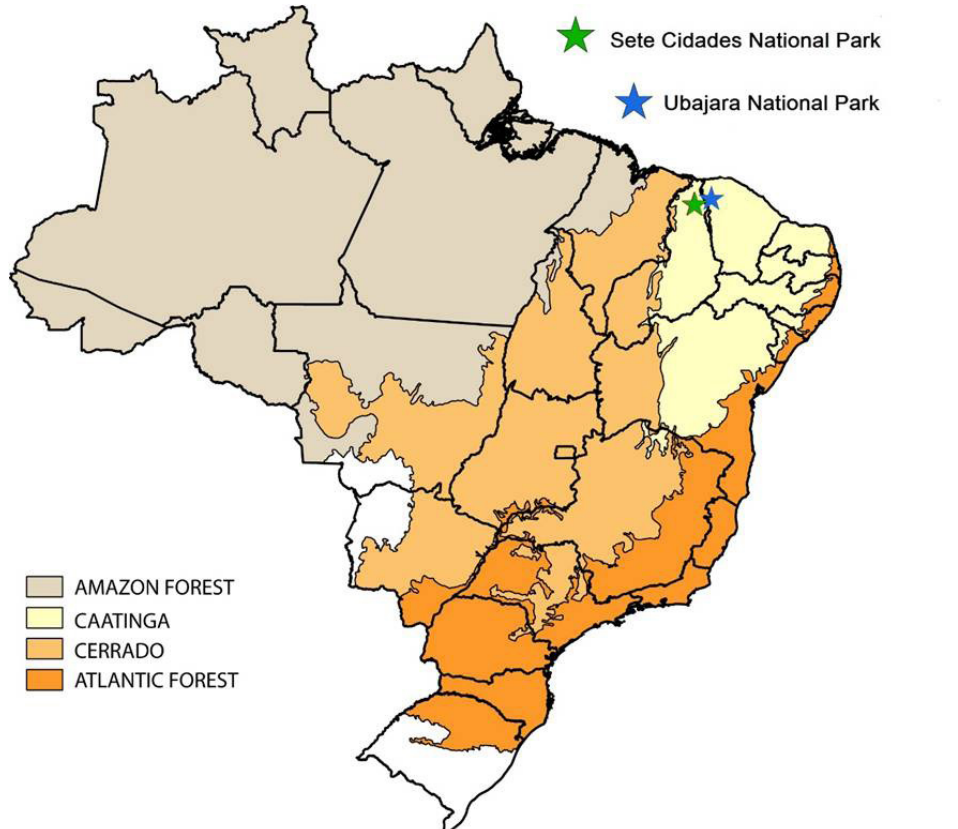
Fig 1 . Map of Brazilian states colored by four major phytogeographical domains: Amazon forest, Cerrado, Atlantic forest, and Caatinga; the last one including Sete Cidades (green star) and Ubajara (blue star) National Parks (Figure from Takiya et al.,